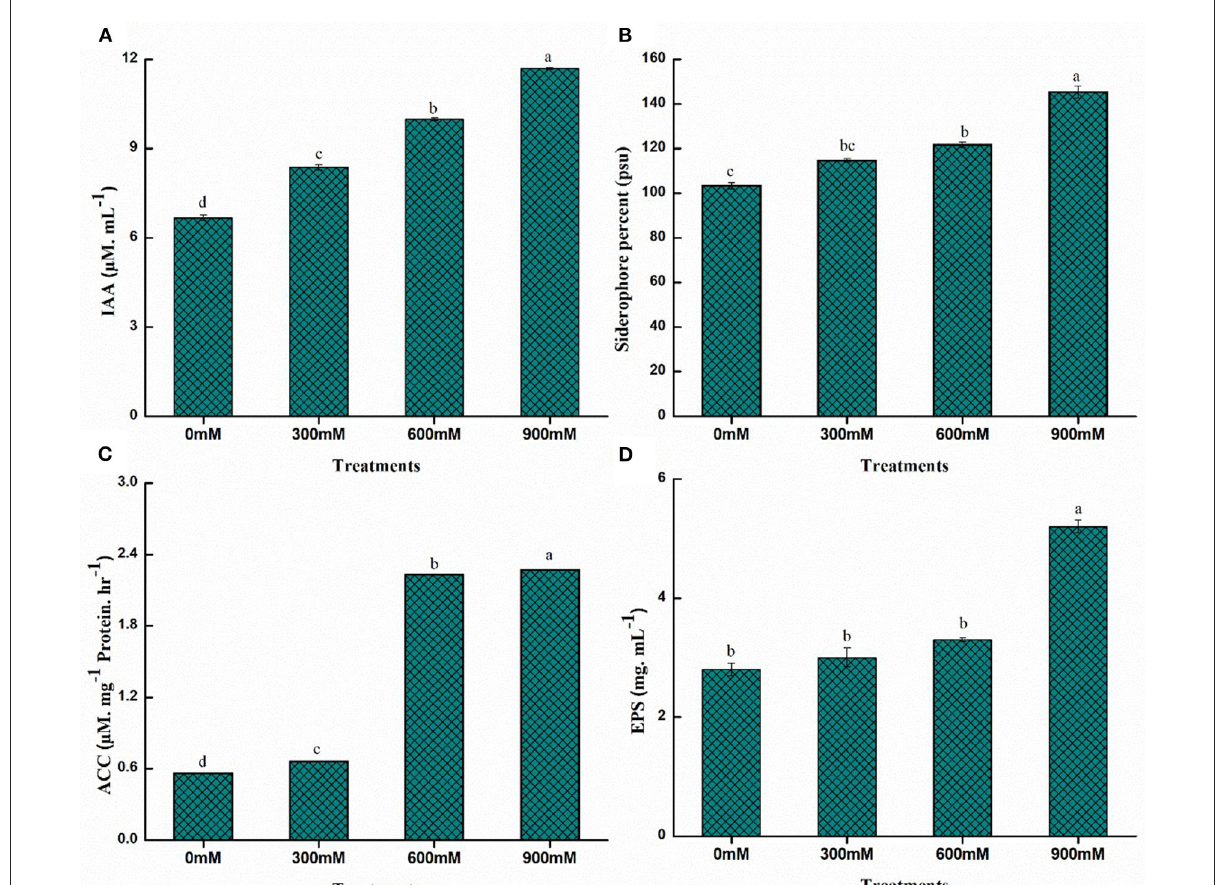
FIGURE3 Quantitative estimation of PGP traits of PM25 under salinity stress: (A) IAA (B) Siderophore (C) ACCD (D) EPS. Bars sharing different letter (s) for each parameter are significantly different from each other according to the LSD test ( p ≤ 0.05). All the data represented are the average of three replications ( n = 3). Error bars represent the standard errors (SE) of three replicates.